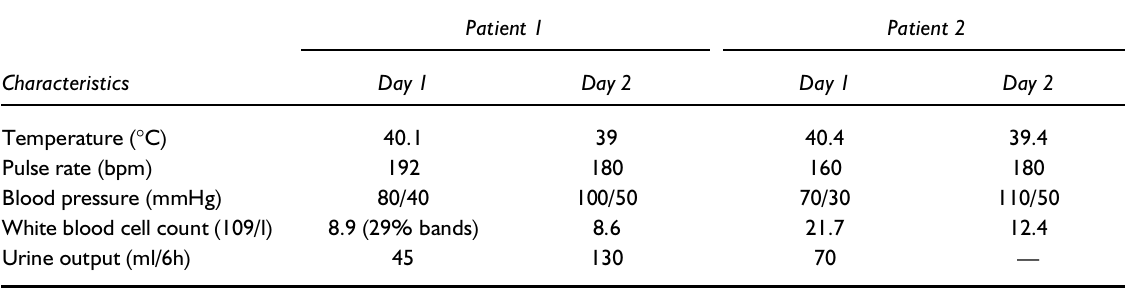
Table 1 Patient characteristics on admission (day 1) and after 1 day of aggressive supportive intensive care